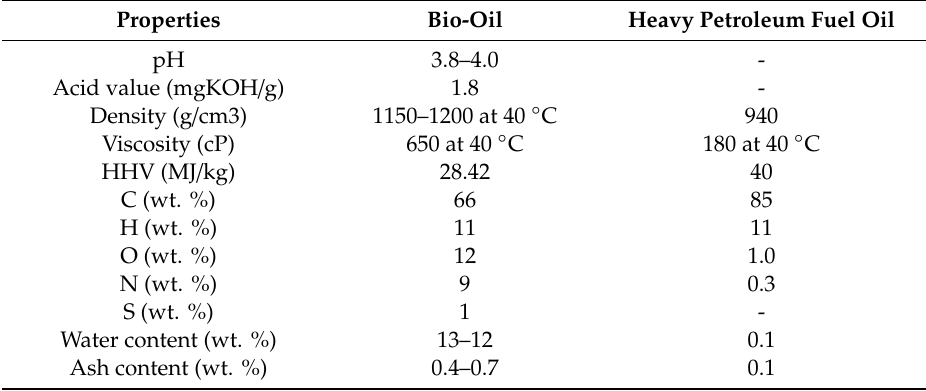
Table 6. Physical characteristics of liquefaction-derived bio-oil and heavy petroleum fuel